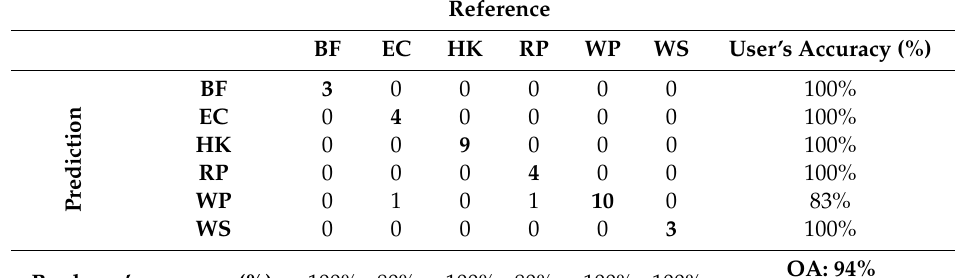
Table 12. Confusion matrix of the RF model for the hierarchical approach: conifer species classification. BF: Balsam Fir, EC: Eastern White Cedar, HK: Eastern Hemlock, RP: Red Pine, WP: White Pine, WS: White Spruce. OA: Overall accuracy, KIA: Kappa Index of agreement.